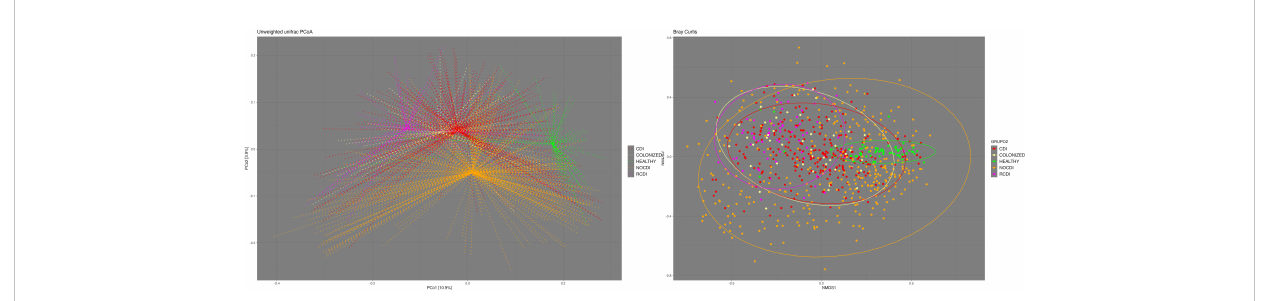
FIGURE 2 Beta- diversity. Left: Principal Coordinates Analysis (PCoA) based on unweighted UniFrac distances. Right: Non-metric multidimensional scaling (NMDS) plot based on the Bray-Curtis dissimilarity index. CDI, Clostridioides dif fi cile infection; NOCDI, No C. dif fi cile diarrhoea; RCDI, recurrent CDI; Colonized, patients colonized with C. dif fi cile ; Healthy, Healthy subjects.